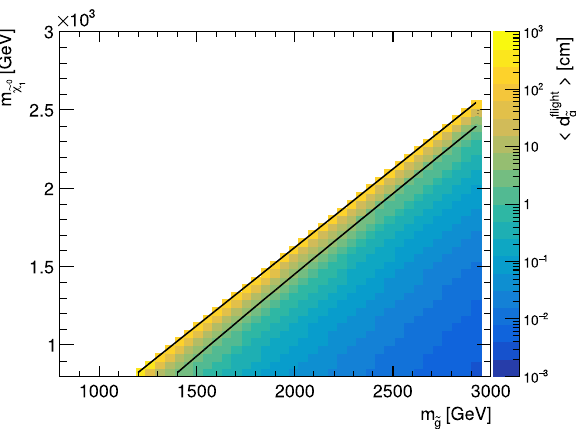
Fig. 66 Average flight distance in the laboratory frame of the gluino (cid:3) d flight (cid:4) as a function of the gluino mass m ˜ ˜ g m ˜ χ 0 for a fixed value of the stop mass m ˜ t = 500 TeV and ˜ χ 0 1 black lines represent the geometrical limits of the tracker volume. The white region is forbidden from the constraint m ˜ χ 0